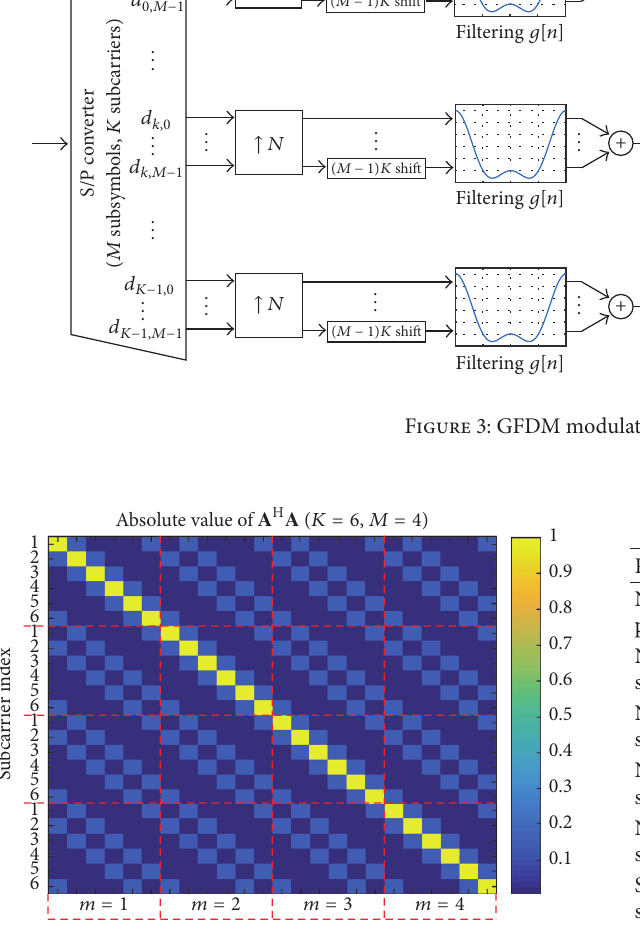
Figure 4: ICI effect of the GFDM (Root Raised Cosine filter with roll-off factor 0.1. 𝐾 = 6, 𝑀 = 4 ).